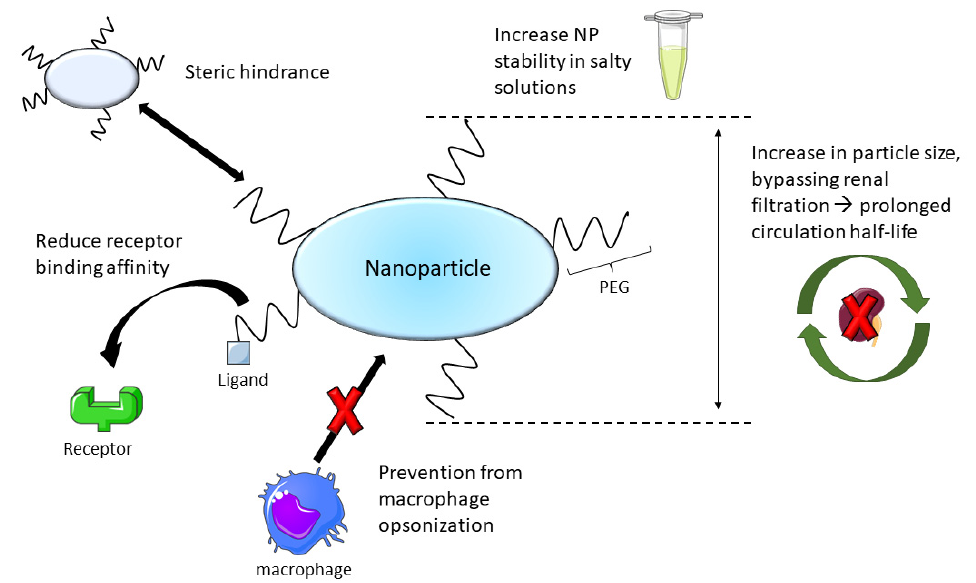
Figure 4. Schematic depiction of the impact of PEGylation on NPs. PEGylation is a common strategy to modify and further functionalize NPs. It was shown that the use of PEG increased NP size and therefore prolonged the circulation half-life by evading renal filtration [29,137]. Moreover, it led to a reduction in receptor binding affinity [133], provokes steric hindrance [131], increased the NP stability in salty environment [140] and it prevented the NPs from opsonization by macrophages [138]. By the PEGylation of proticles, many of these effects can be adopted for functionaliza- tion. Lochmann et al. administered PEG 20,000 in order to use it as stabilizer for Proticles in salt solutions. In this work, the binary proticles were produced and afterwards incubated in various PEG-20,000 solutions, which represents a kind of coating process. They suc- ceeded in their goal in increasing their stability in cell medium but because of physiological incompatibilities, further developments are required [140]. In accordance to PEGylated proticles, Fresacher et al. applied another functionalization method in which protamine was derivatized with diethylenetriaminepentaacetic acid (DTPA) and PEGylated with PEG-2000 before nanoparticle formation. A comparison of PEGylated and non-PEGylated Proticles with respect to their in vitro stability and in vivo biodistribution was performed. For this reason, the Proticles were radiolabeled with 111 In 3+ . Nanoparticle stability